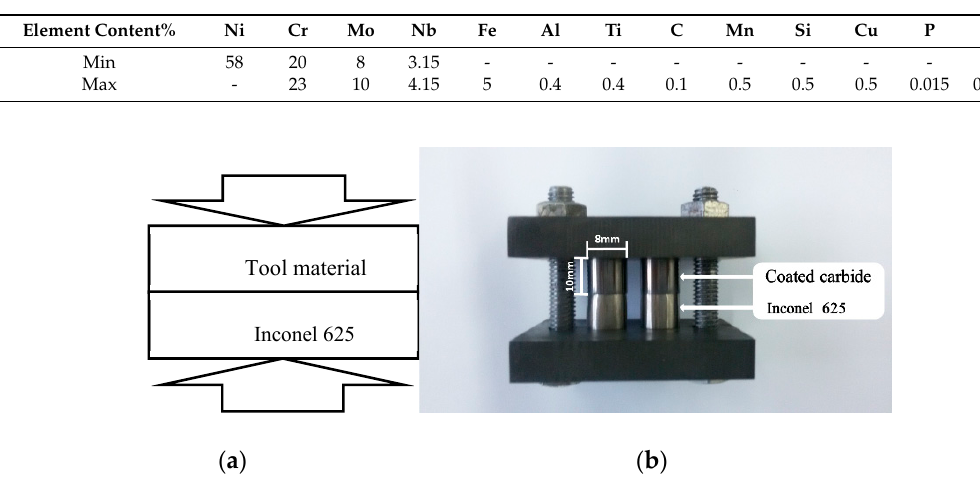
Table 2. Element composition of Inconel 625.